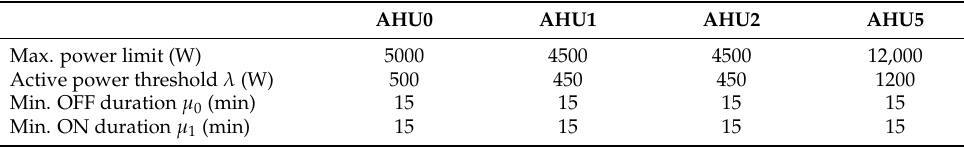
Table 4. Parameter information for obtaining the activation state of the AHU